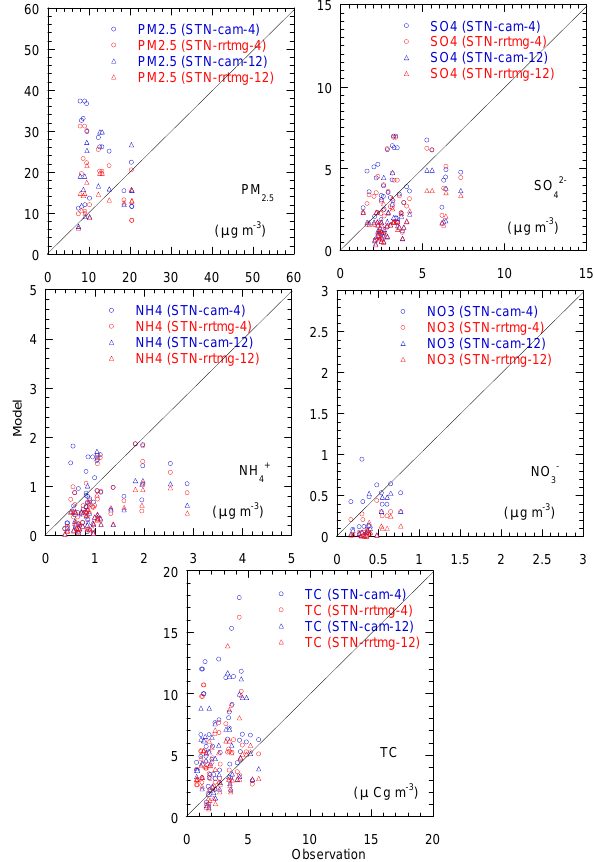
Observation Figure 7. Comparison of observed and modeled CAM (WRF– Figure 7. Comparison of observed and modeled (CAM(WRF-CMAQ/CAM) and RRTMG (WRF- CMAQ/RRTMG)) PM 2.5 and its chemical composition at the STN sites over the eastern Texas from the CMAQ/CAM) and RRTMG (WRF–CMAQ/RRTMG) PM 2 . 5 and simulations at 4-km and the 12-km resolution model grids its chemical composition at the STN sites over eastern Texas from the simulations on the 4km and 12km resolution model